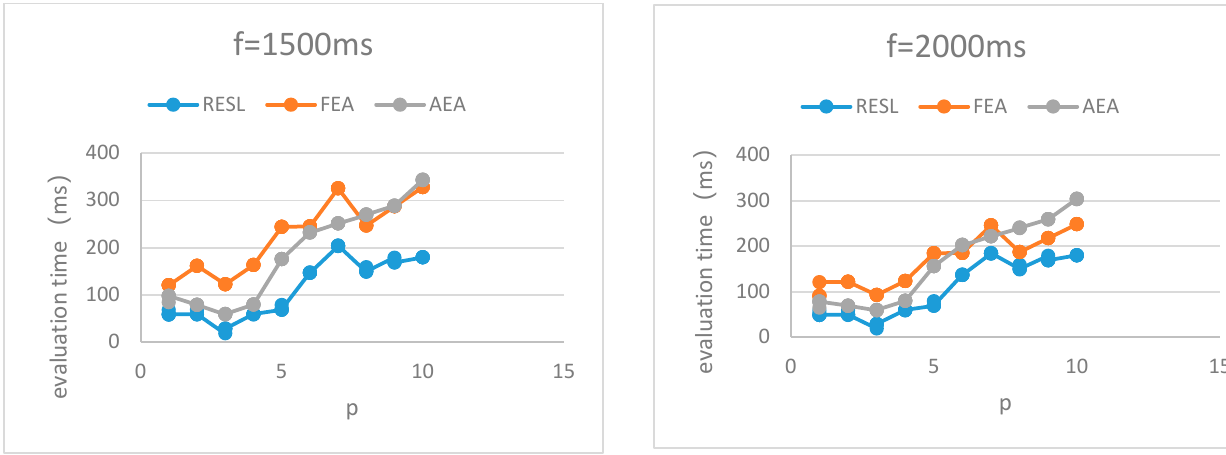
Figure 4. Evaluation time.